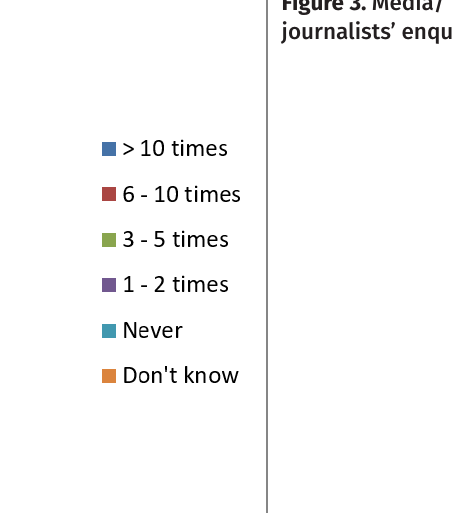
Figure 3. Media/ journalists’